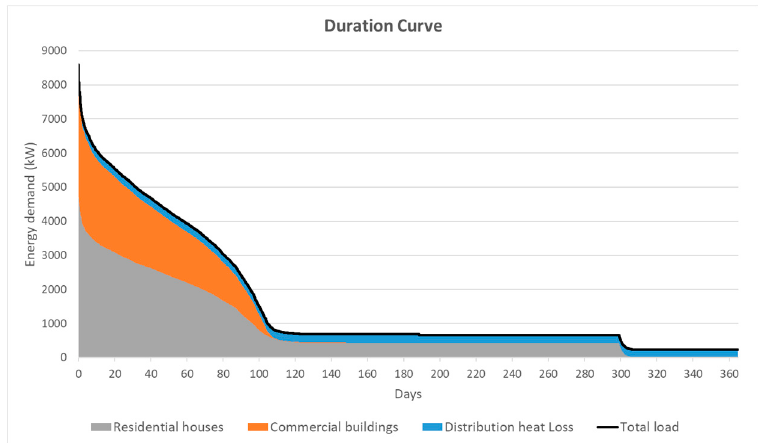
Figure 8. Network duration curve for the new urban area.